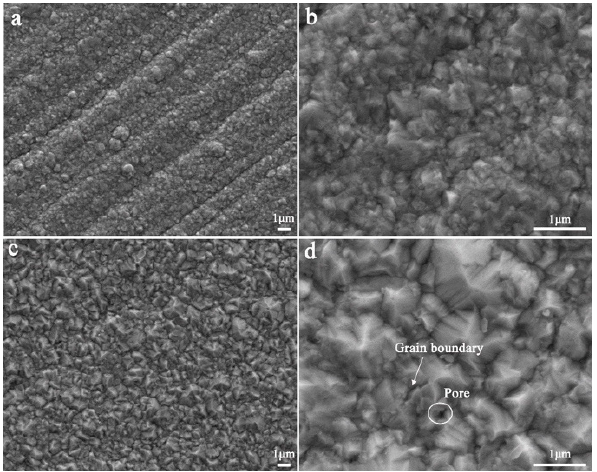
Figure 2. The samples with 5.76 × 10 − 3 mg/mm 2 Ni coating ( a , b ) and with 34.70 × 10 − 3 mg/mm 2 Ni coating ( c , d